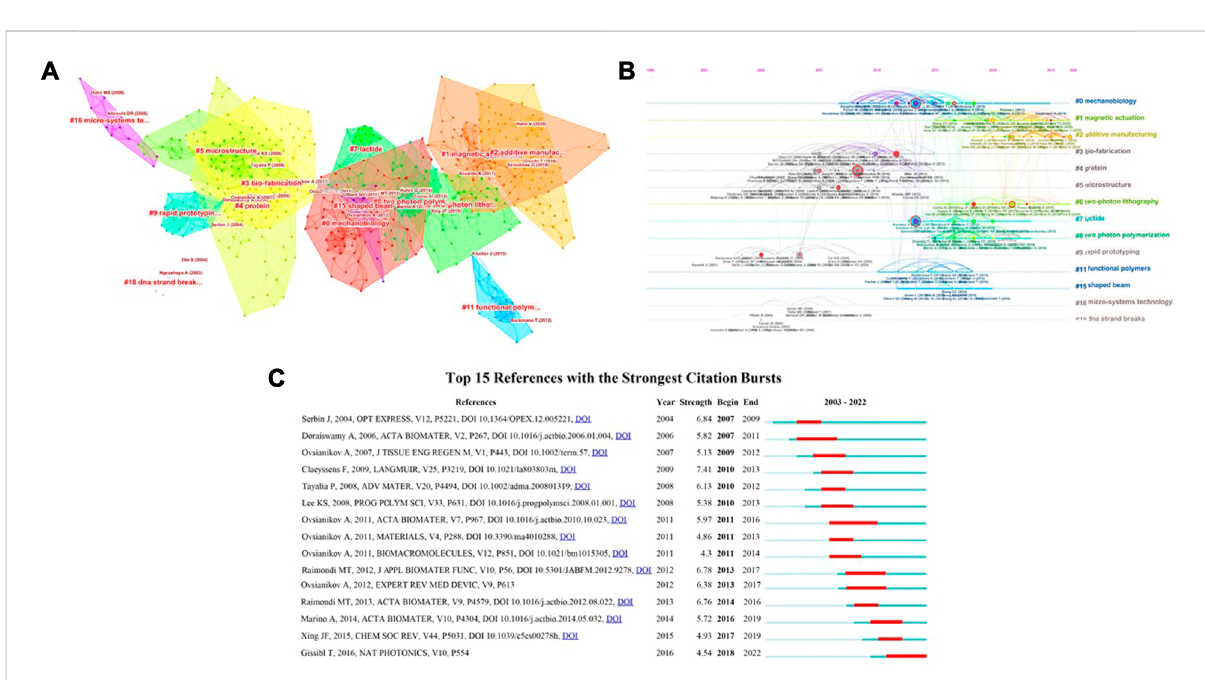
FIGURE 8 The analysis of references in publications on applications of TPP in biomedical fi eld. (A,B) The visualized network and clustering timeline of the co-cited references; (C) Top 19 References with the Strongest Citation